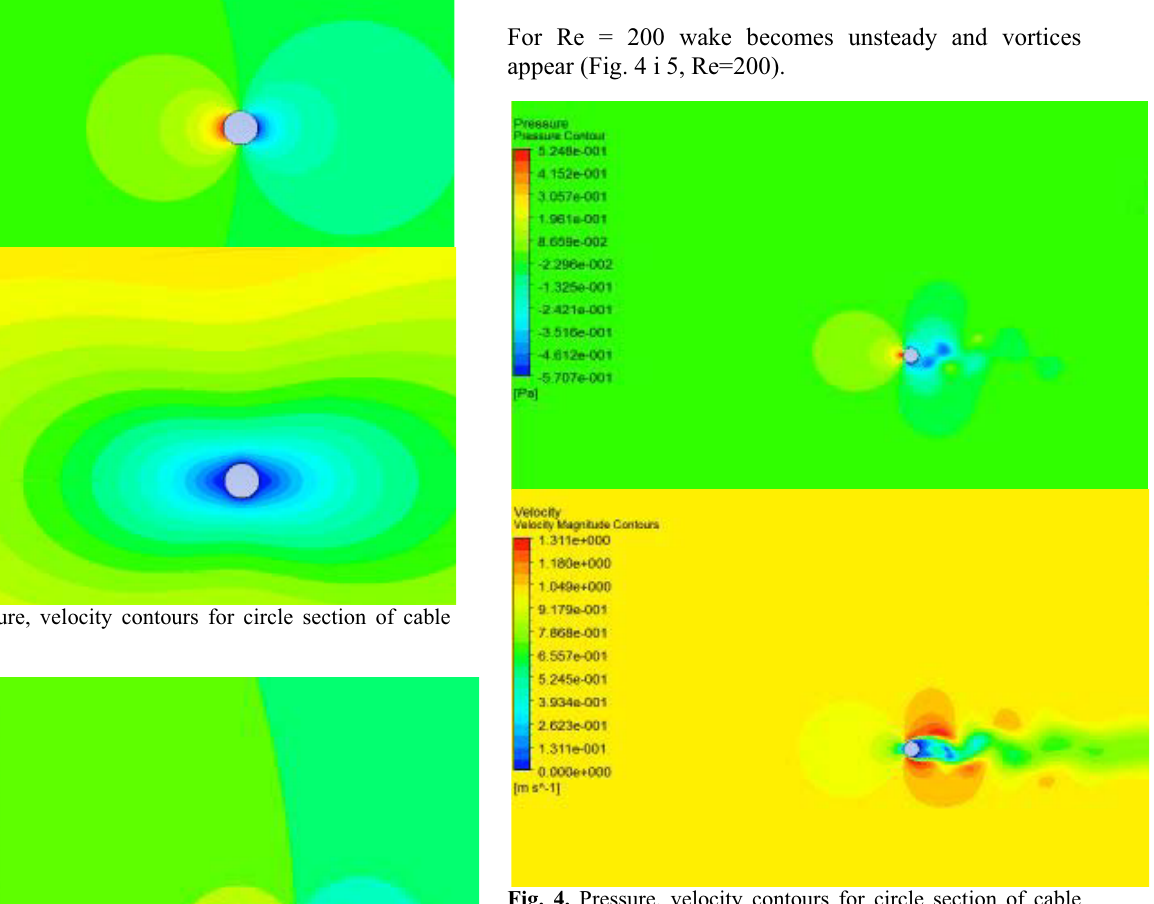
Fig.3. Pressure, velocity for elipse section and Re=0,01.